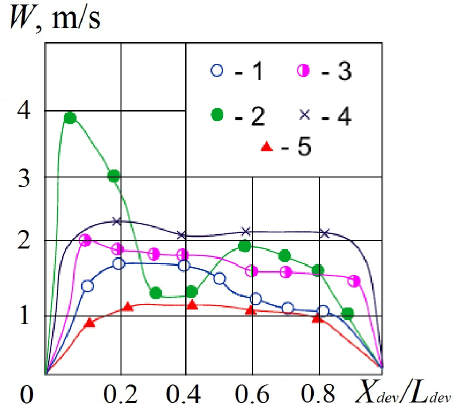
Figure 4. The distribution of gas flow velocities along the section length of the device where the shelf is installed: 1— L cl /L dev = 0.5, ψ = 15%; 2— L cl /L dev = 0.15, ψ = 15%; 3— L cl /L dev = 0.15, ψ = 30%; 4— L cl /L dev = 0; 5— L cl /L dev = 1. Tilt angle of the shelf— γ = 25°. Gas flow velocity in the free cross-sec- tion—1.2 m/s.